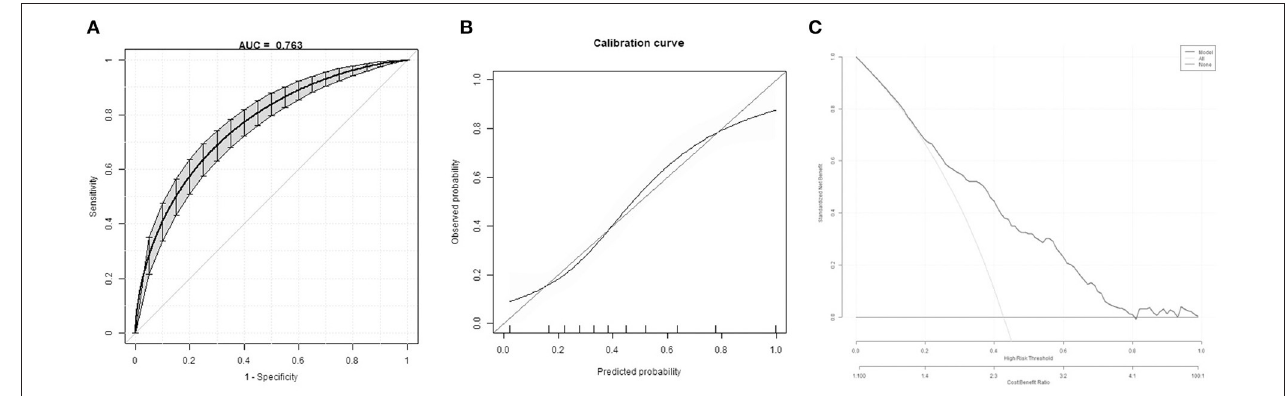
FIGURE 2 | Model internal validation. (A) Discrimination of the prediction model by the bootstrap method. (B) Calibration plots of the model by the bootstrap method. (C) Decision curve of the model.